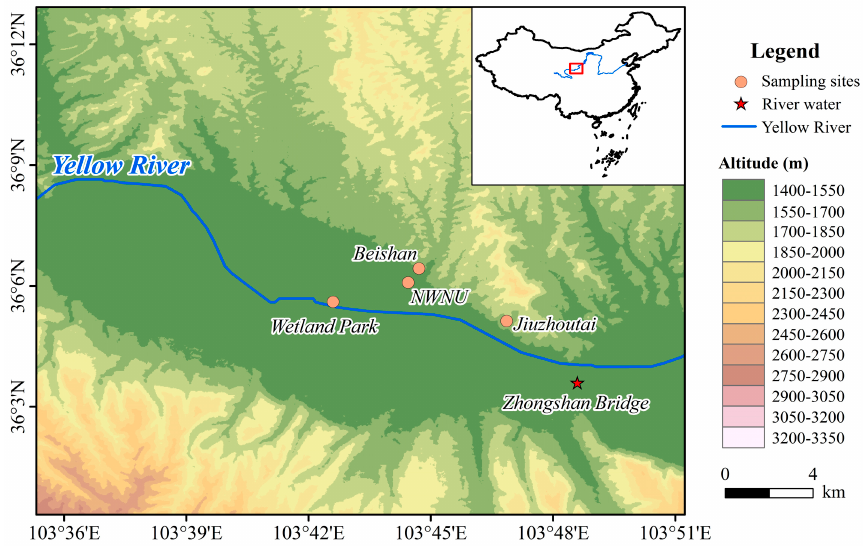
Figure 1. Spatial distribution of the sampling sites of different water bodies in Lanzhou City.